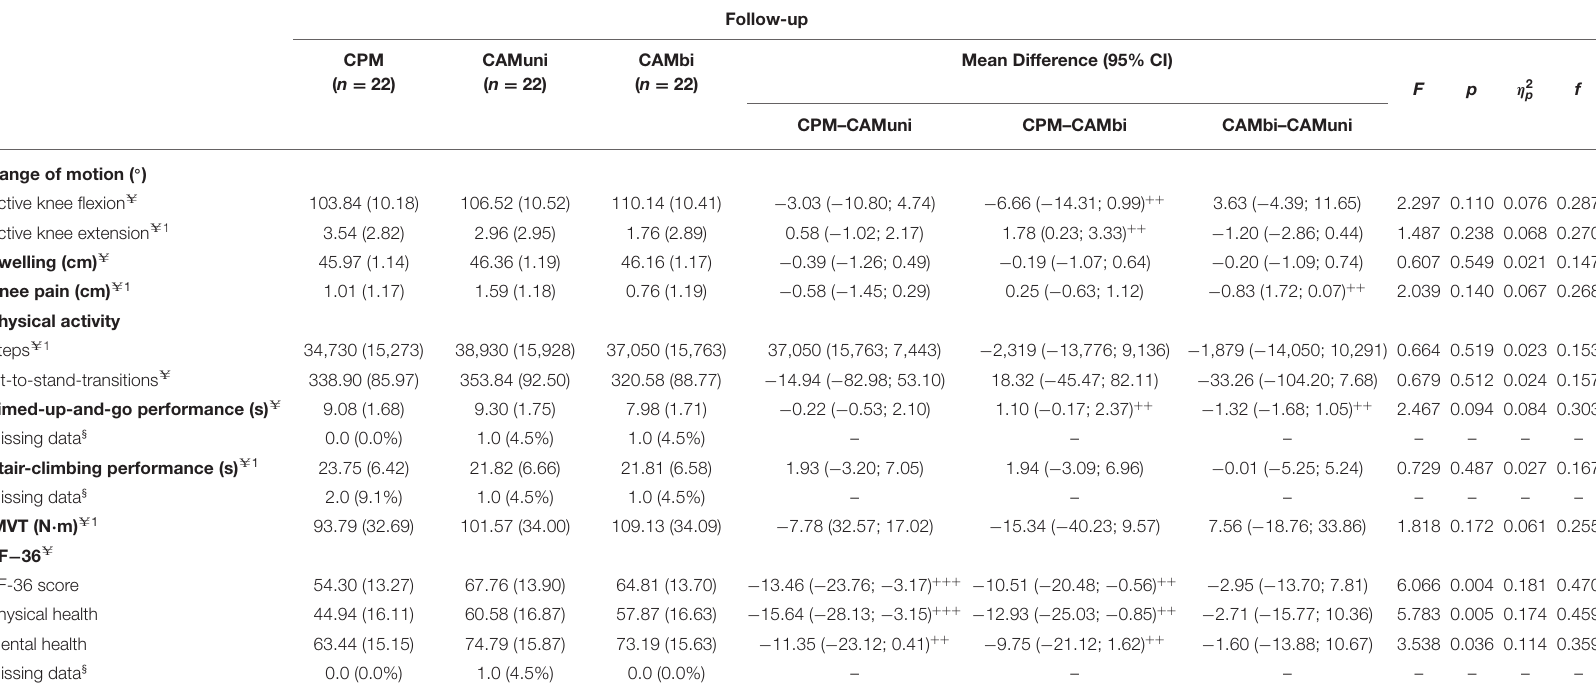
TABLE 4 | Measures of clinical, functional and quality of life outcomes at follow-up (modified intention-to-treat analysis).